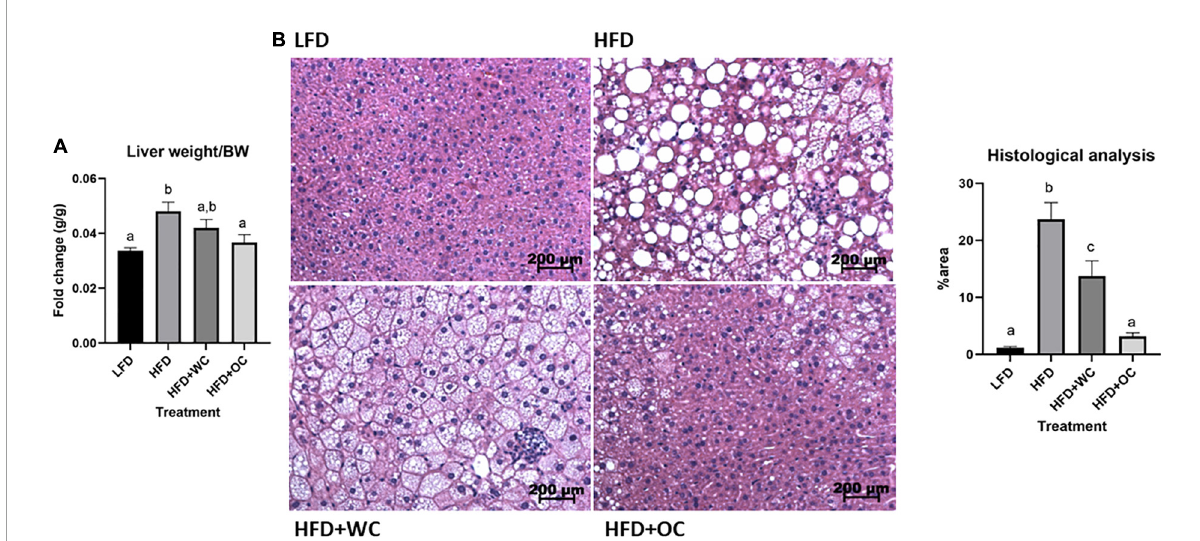
FIGURE2 Orange carrot-rich diet improved status of HFD-induced hepatic steatosis. (A) Graphical representation of liver weight-to-body weight (BW) ratio. LFD: n = 11; HFD, HFD + WC, HFD + OC: n = 12. (B) Hematoxylin and eosin (H&E) staining of livers, percentage of area covered by lipid deposits at 20 X magnification. Liver weight was analyzed by one-way ANOVA with post hoc Tukey HSD. Liver histology was analyzed by using the Kruskal-Wallis test with post hoc Tukey HSD. Letter differences indicate statistical significance ( p <